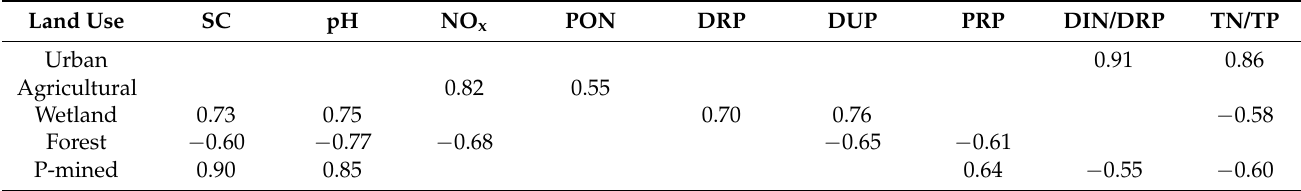
Values ≥ 0.64 indicate significant relationships ( p < 0.05), while the others (<0.64) refer to marginally significant level ( p <